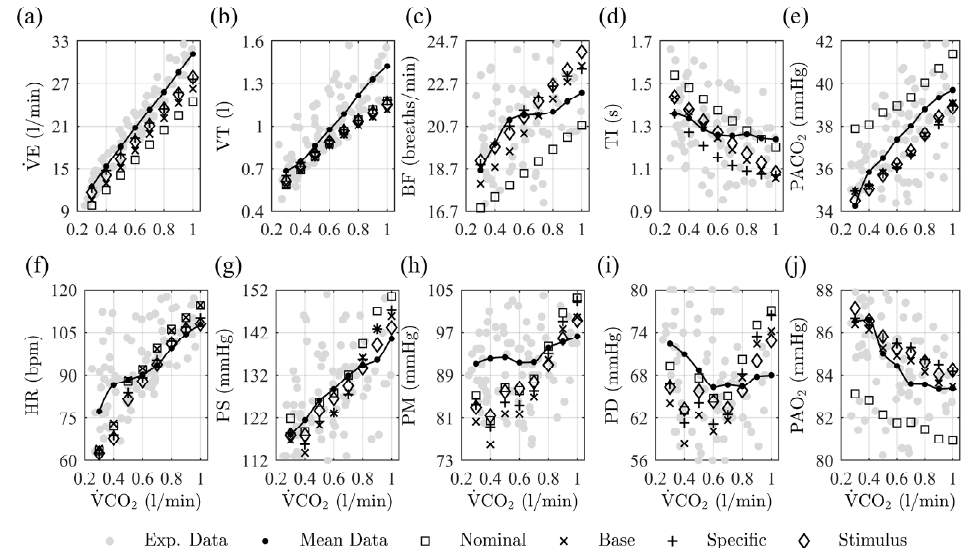
Figure 4. Steady-state model predictions for each cardiorespiratory variable evaluated. Results are shown as a function of 𝑉(cid:4662) 𝐶𝑂 (cid:2870) values. Gray dots denote the experimental data limited at each sub- ject’s AT; the black dot-line the experimental data average; the square marker the model predictions under nominal conditions (Nominal); the cross marker the predictions of the model at the first fitting stage (Base); the plus sign marker the model predictions at the second fitting stage (Specific); and the diamond marker the model predictions at the third fitting stage (Stimulus). The subfigures from ( a ) to ( j ) correspond to the result for each of the variables evaluated.